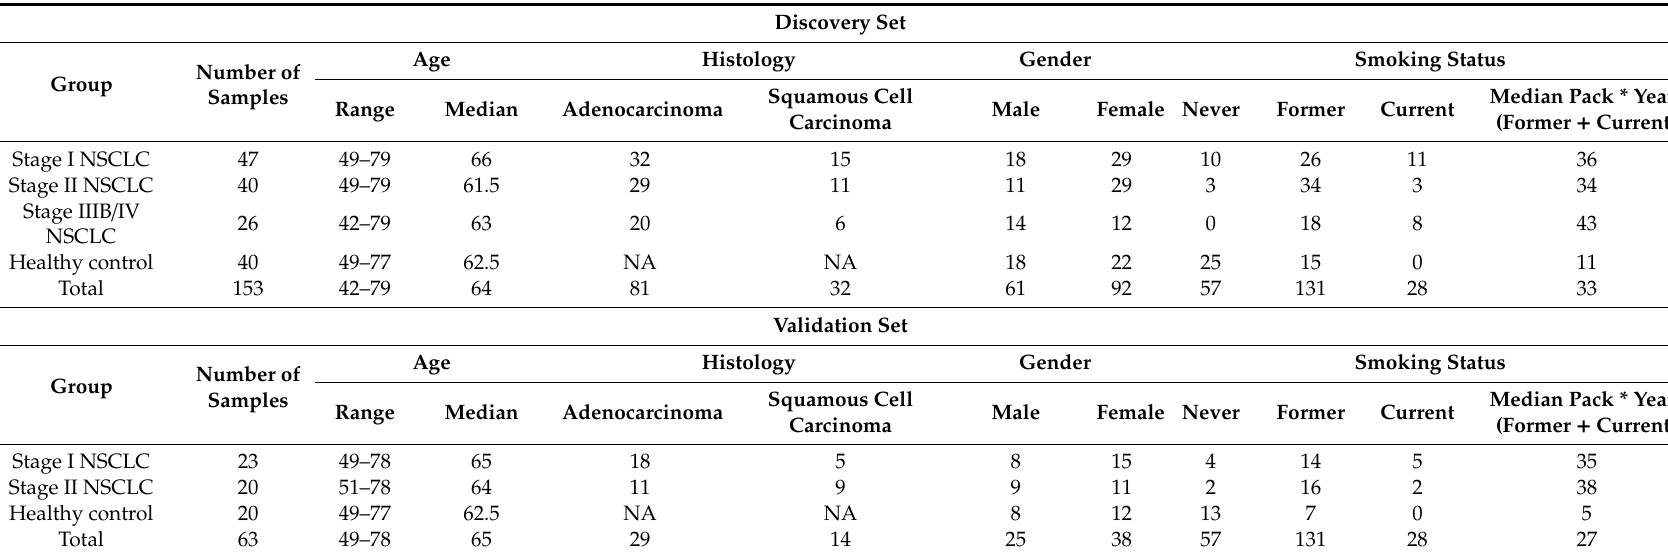
Table 1. Summary of grouping of